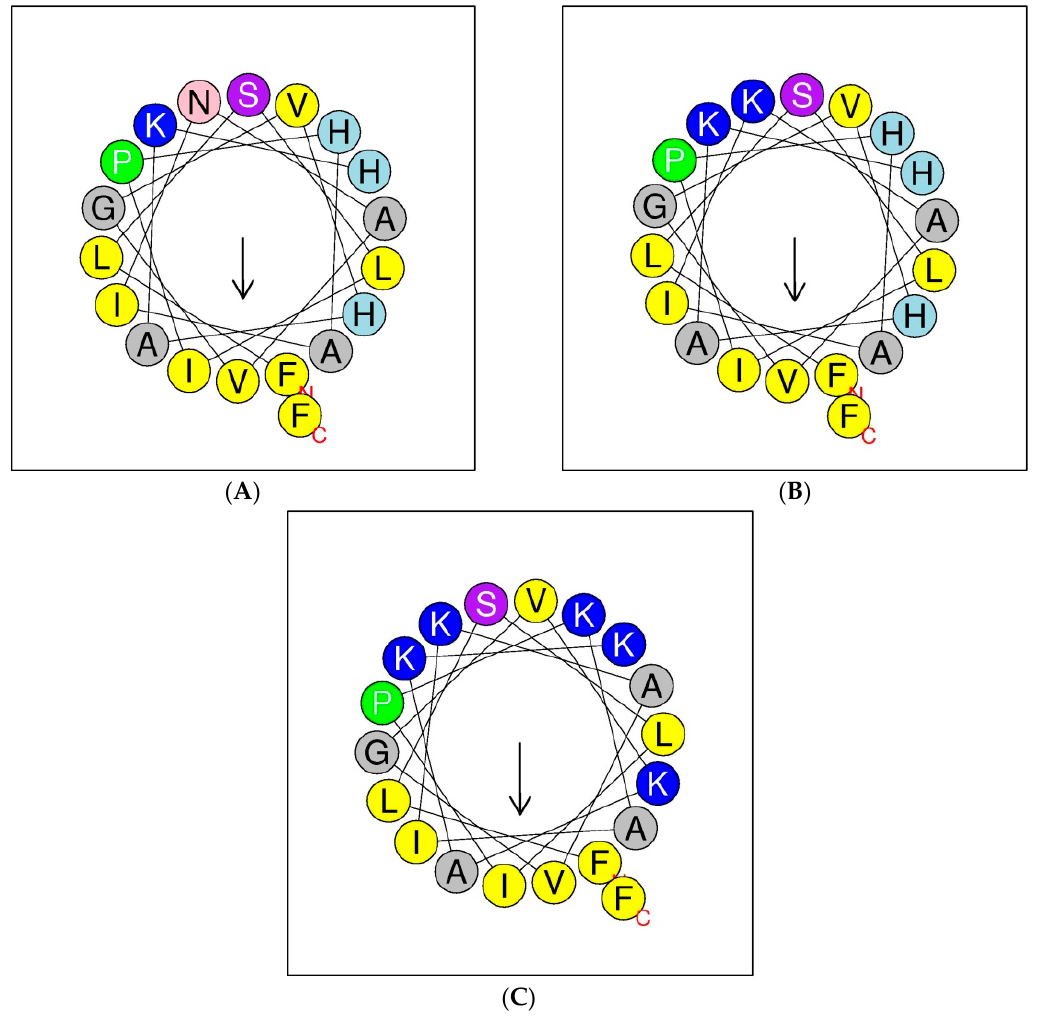
Figure 4. Putative secondary structures of PS-PT ( A ), PS-PT1 ( B ) and PS-PT2 ( C ) described by helical wheel projections. Arrows denote the direction of the hydrophobic moments.